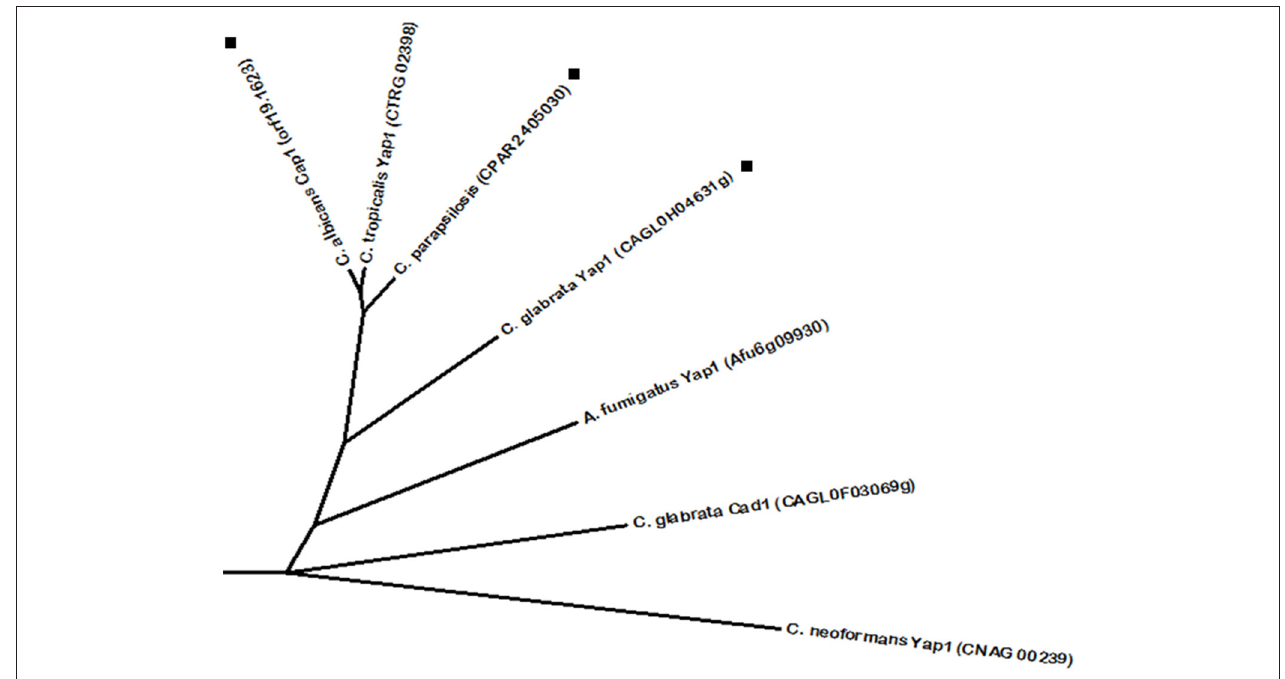
FIGURE 5 | Phylogenetic analysis of the C. albicans Cap1 homologs. Phylome predicted homologs of Cap1 are marked with ( (cid:4) ). Unmarked branches represent additional proteins showing some degree of similarity identified by BLASTp ( E < 10 − 50 ). The tree was constructed using the Molecular Evolutionary Genetics Analysis (MEGA 7) software ( Kumar et al., 2016). Multiple alignments of the amino acid sequences were calculated by ClustalW algorithm (Sneath and Sokal, 1973 ). The tree is drawn to scale, with branch lengths in the same units as those of the evolutionary distances used to infer the phylogenetic tree. The evolutionary distances were computed using the JTT matrix-based method (Jones et al., 1992) and are in the units of the number of amino acid substitutions per site. The rate variation among sites was modeled with a gamma distribution (shape parameter =